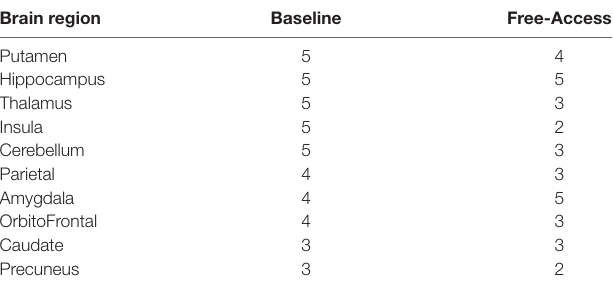
Nodes are considered hubs if they are in the upper 10% of the network for degree. Only nodes considered a hub for at least two subjects at any time point are presented. Note. n = 6. TABLE 5 | The number of subjects for which each brain region was considered a member of the Rich